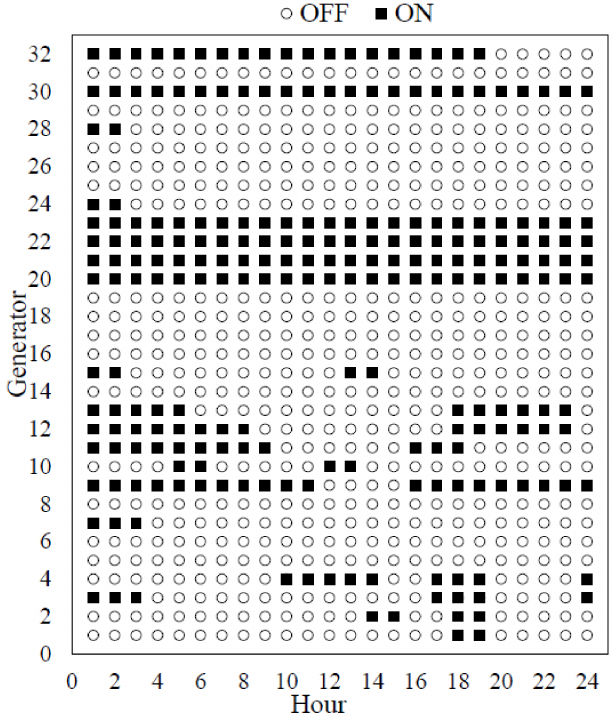
Figure 3. On and off status of thermal power units.